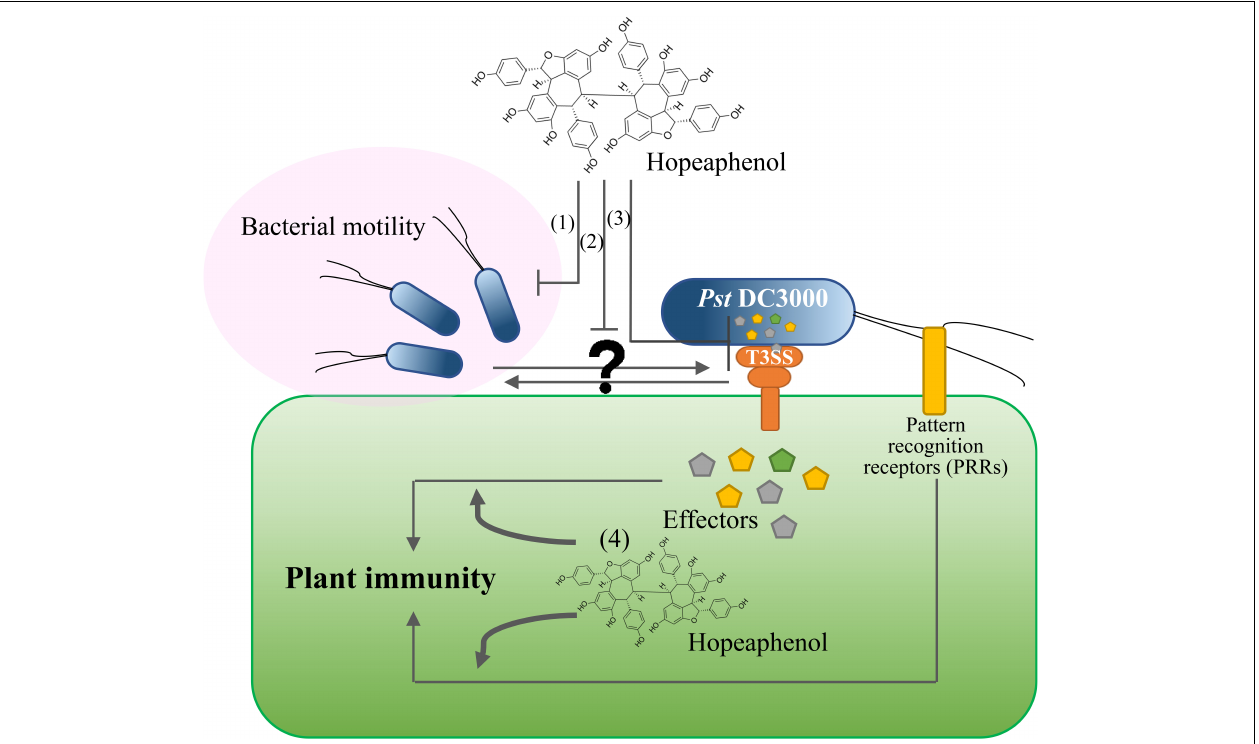
FIGURE 2 | Hopeaphenol has a dual role in bacterial virulence and plant innate immunity. (1) Hopeaphenol suppresses the virulence activity of pathogens by directly inhibiting bacterial motility. (2, 3) Hopeaphenol modulates the expression of genes encoding effector proteins, subsequently alleviating pathogen virulence. (4) Hopeaphenol may enhance local immune responses mediated by two-layered plant innate immunity.